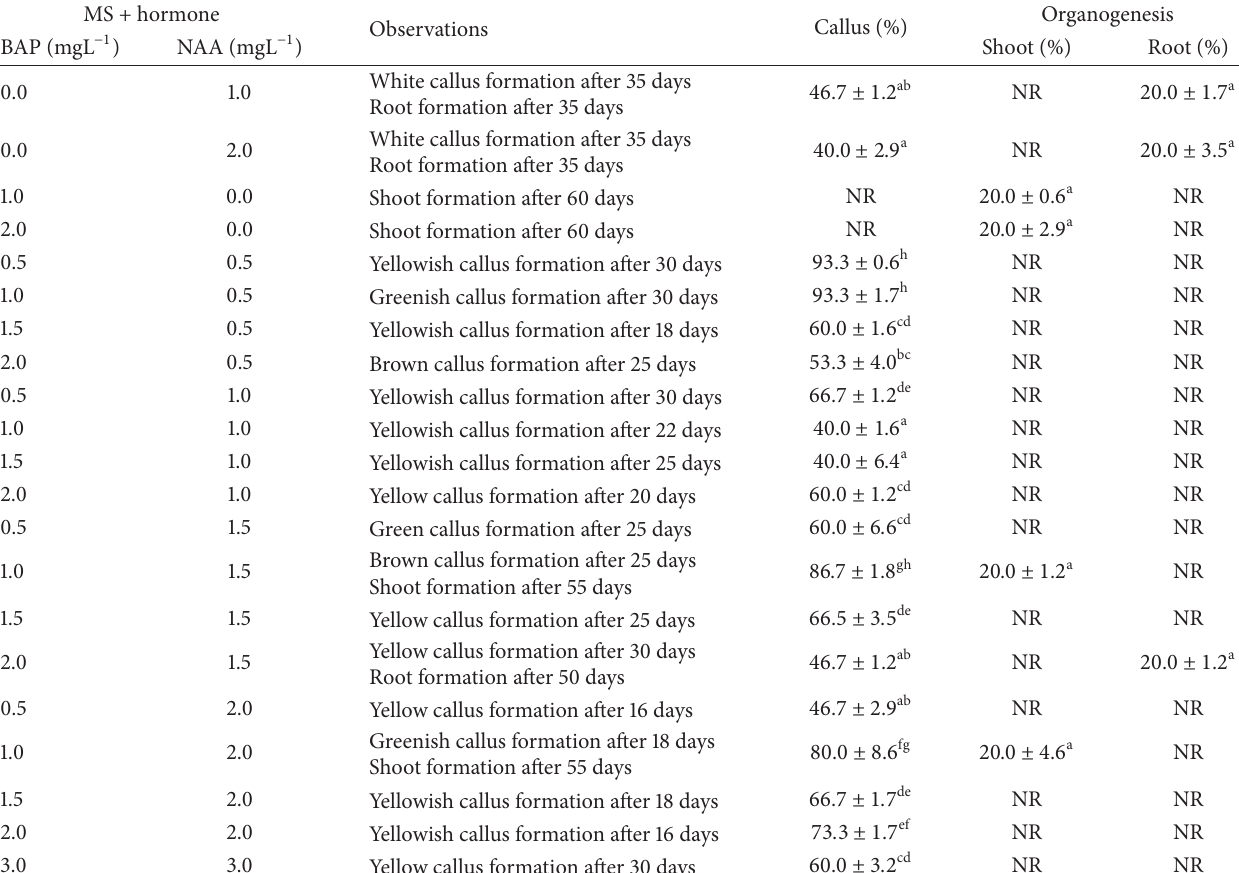
Table 2: The effects of different combinations and concentrations of BAP and NAA on root explants of Citrus hybrids , cultured on solid MS media at 25 ± 1 ∘ C. Cultures were maintained at 16 hours of light and 8 hours of darkness, with 1000 lux intensity of light. MS +